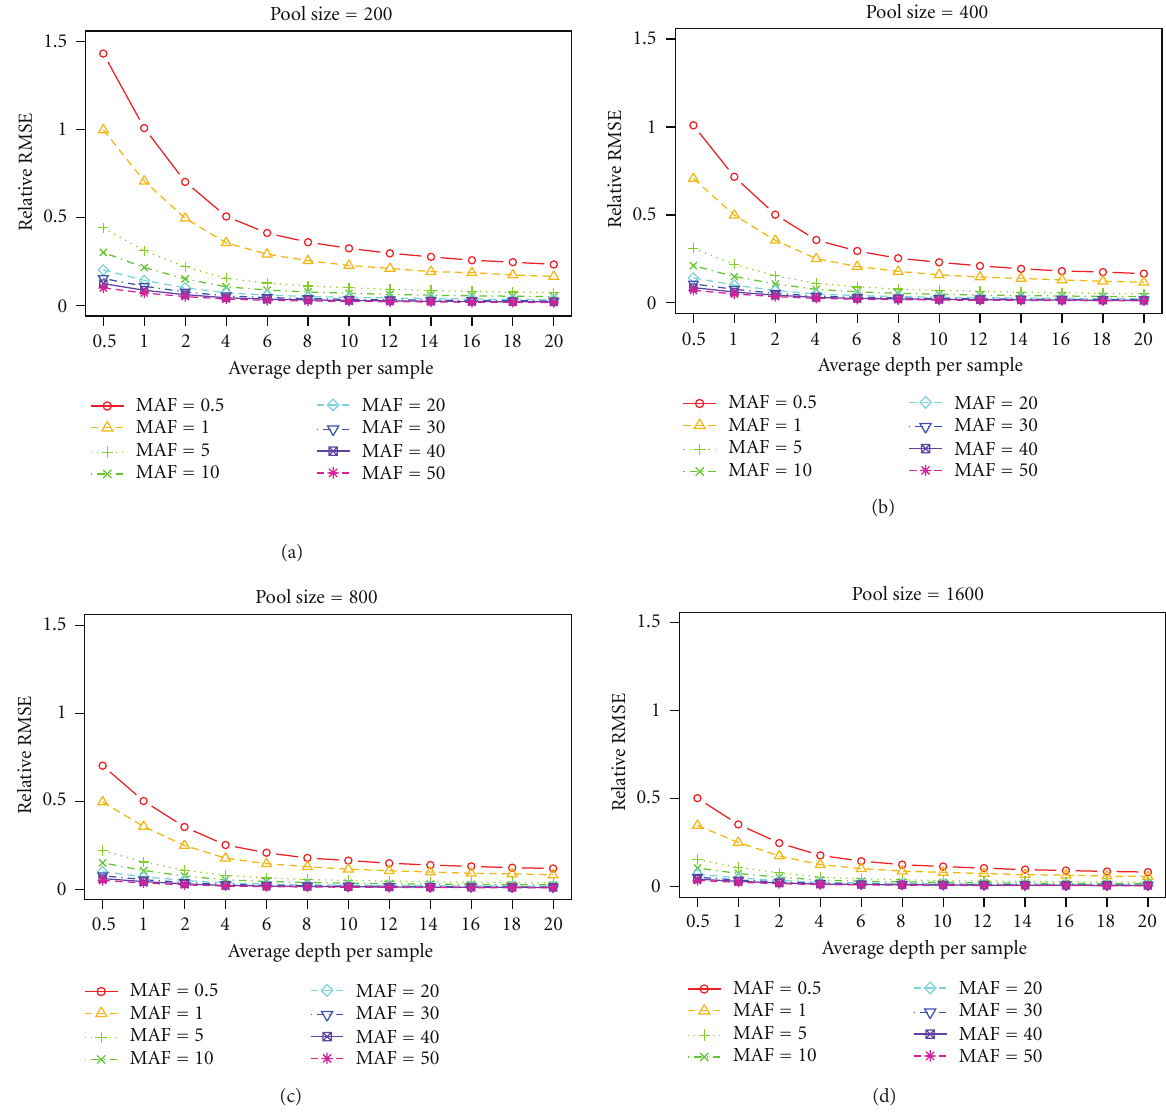
Figure 2: Relative RMSE for different pool sizes and MAFs under different average per sample depths.